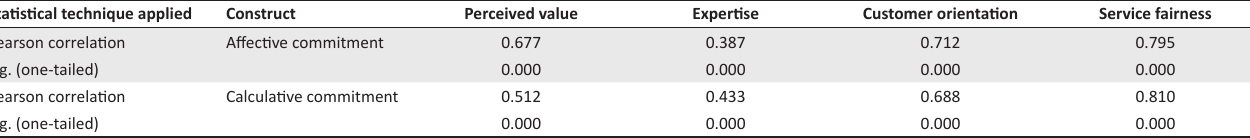
TABLE 4: Correlation and collinearity statistics.